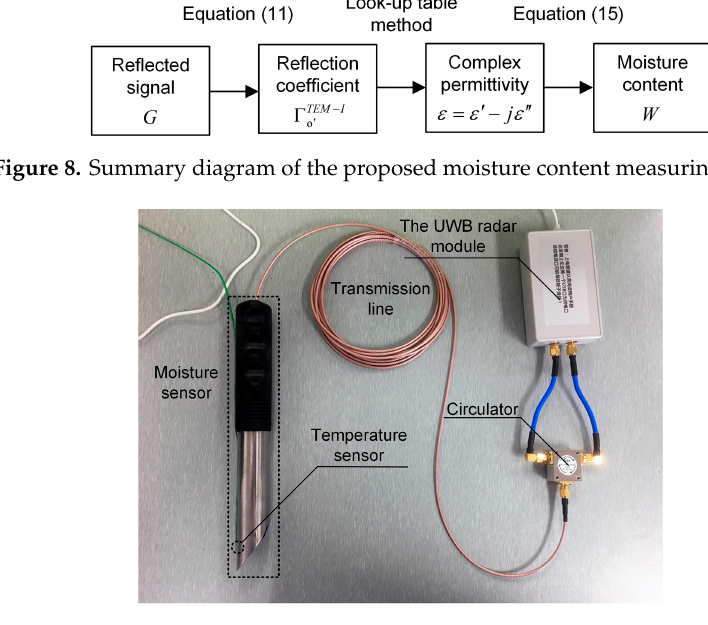
Figure 9. The photograph of the developed device for measuring the moisture content of different types of grains.